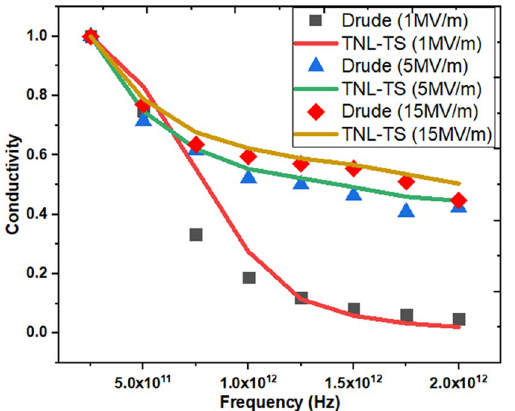
Figure 3. Complex conductivities at Peak THz Intensity 1, 5, 15 MV/m with ramping THz Frequencies. Conductivities extracted from the Monte Carlo simulations (solid lines) and symbols represent the conductivities fitted with Drude model 6 .